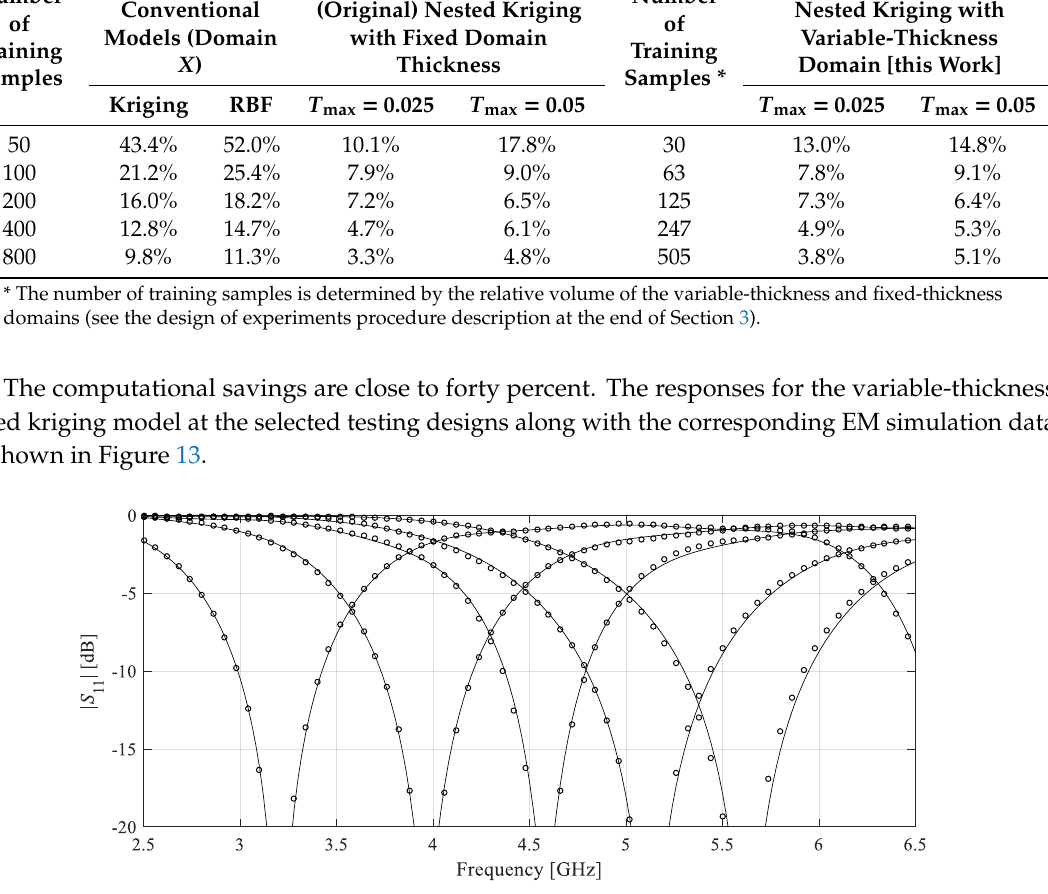
Figure 13. Patch antenna: reflection responses at the selected test designs: EM model (—), nested kriging with variable-thickness domain obtained using 800 training samples and T max = 0.05 (o).